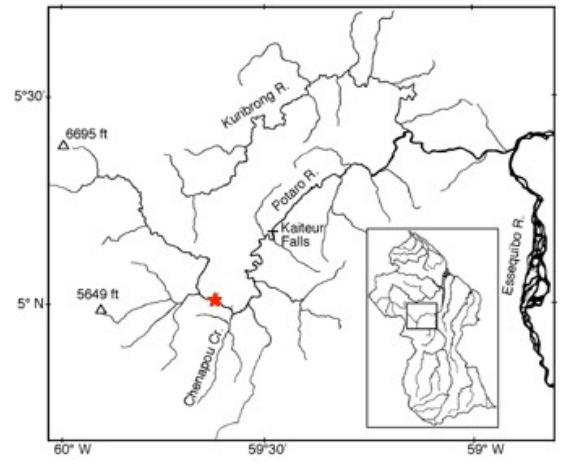
Figure 1. Map showing location of Chenapou (star) on the Potaro river [41]